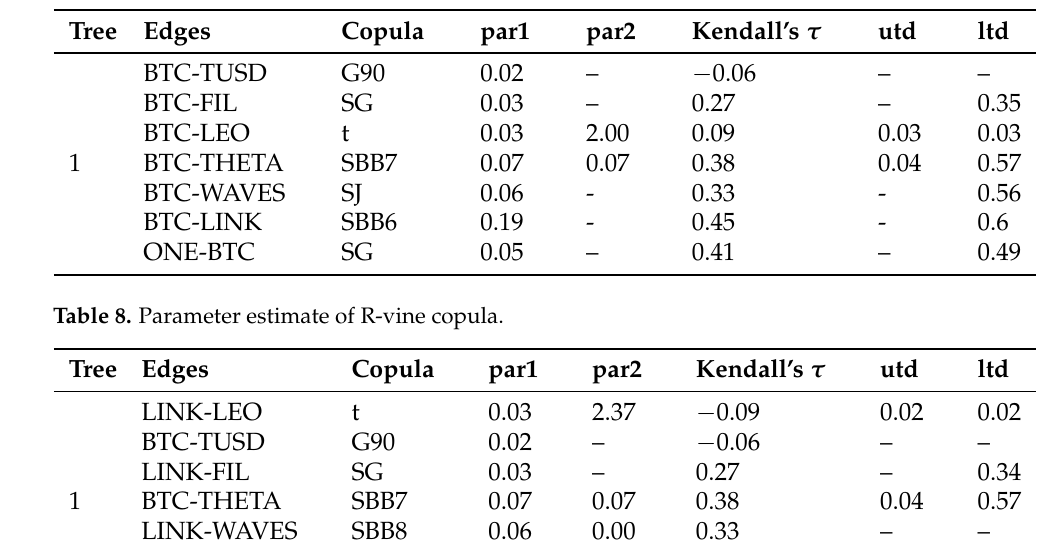
Table 7. Parameter estimate of C-vine copula.